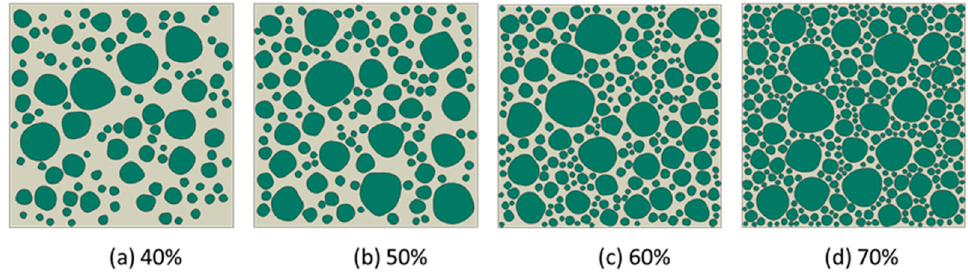
Figure 15. High-sphericity and well-rounded stone concrete models under different aggregate volume fractions, ( a ) 40%, ( b ) 50%, ( c ) 60%, and ( d ) 70%, respectively, with the scale factor between long and short axes, f = 1.